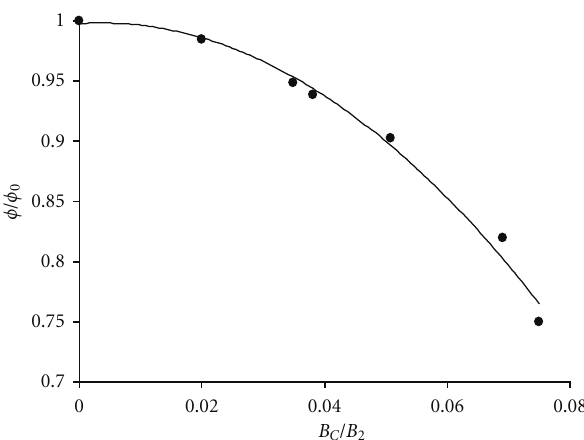
Figure 15: Flow coe ffi cient change with tip clearance.